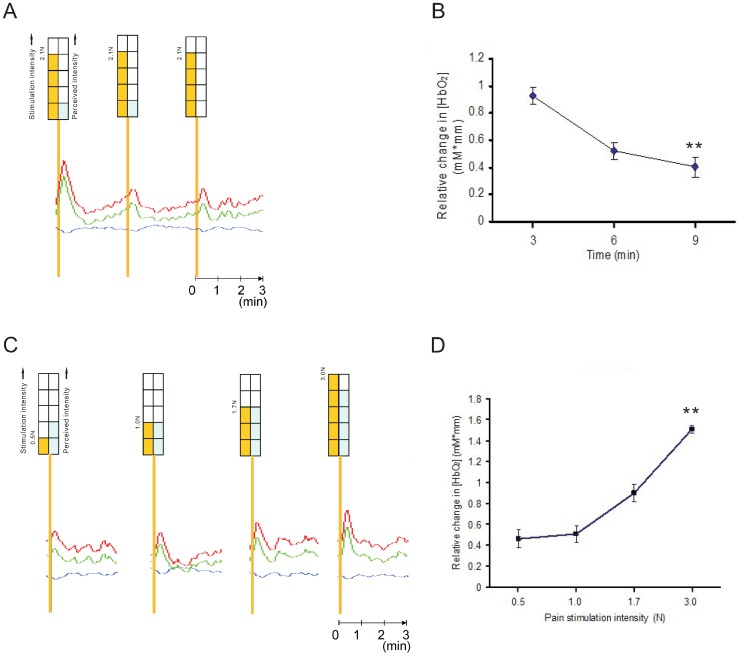
Sequential responses of channel 10 in the frontal area to constant or increasing pain intensities.(A) Responses to sequential applications of constant pain stimulation. The yellow bar represents the pain stimulation intensity (2.1 N) and the blue bar represents the subjective pain score (VAS). Red, blue, and green traces of the dynamic response represent [HbO2], [HbR], and [HbT], respectively. The traces are from channel 10 in the frontal area of subject M-1. (B) Mean (n = 4 subjects) peak responses in [HbO2] in channel 10 in the frontal area. NIRS signals were significantly decreased when constant intensities of stimulation were given (**p<0.05, vs the first response). Error bars represent SD. (C) Responses to applications of increased pain stimulation. The yellow bar represents the pain stimulation intensity (0.5 N, 1.0 N, 1.7 N, and 3.0 N) and the blue bar represents the subjective pain score (VAS). Red, blue, and green traces of the dynamic response represent [HbO2], [HbR], and [HbT], respectively. The traces are from channel 10 in the frontal area of subject M-1. (D) Mean (n = 4 subjects) peak responses in [HbO2] in channel10 in the frontal area when pain stimulation intensity was gradually increased (**p<0.05, vs the response in the first stimulation (0.5 N)). Error bars represent SD.